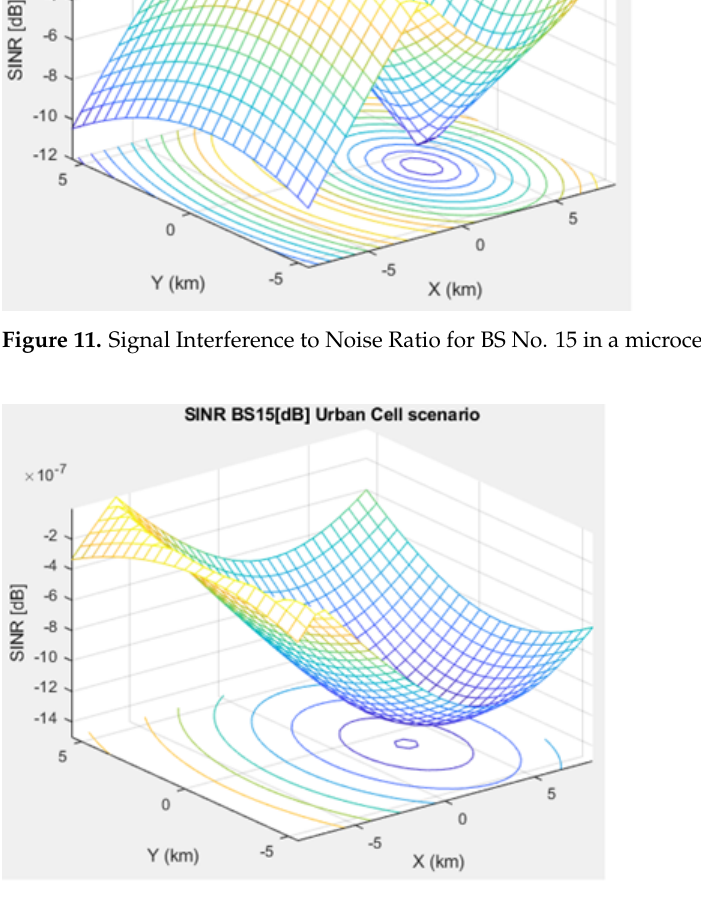
Figure 12. Signal Interference to Noise Ratio for BS No. 15 in an urban macrocell